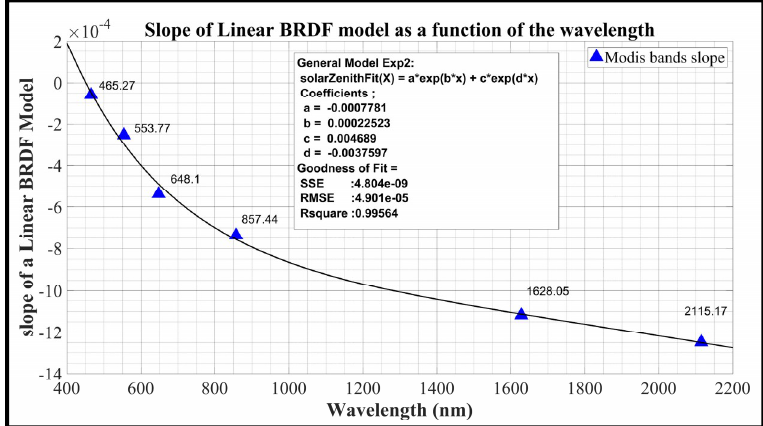
Figure 2. Simple Linear bidirectional reflectance distribution function (BRDF) correction model of Egypt 1 based on solar zenith angle.